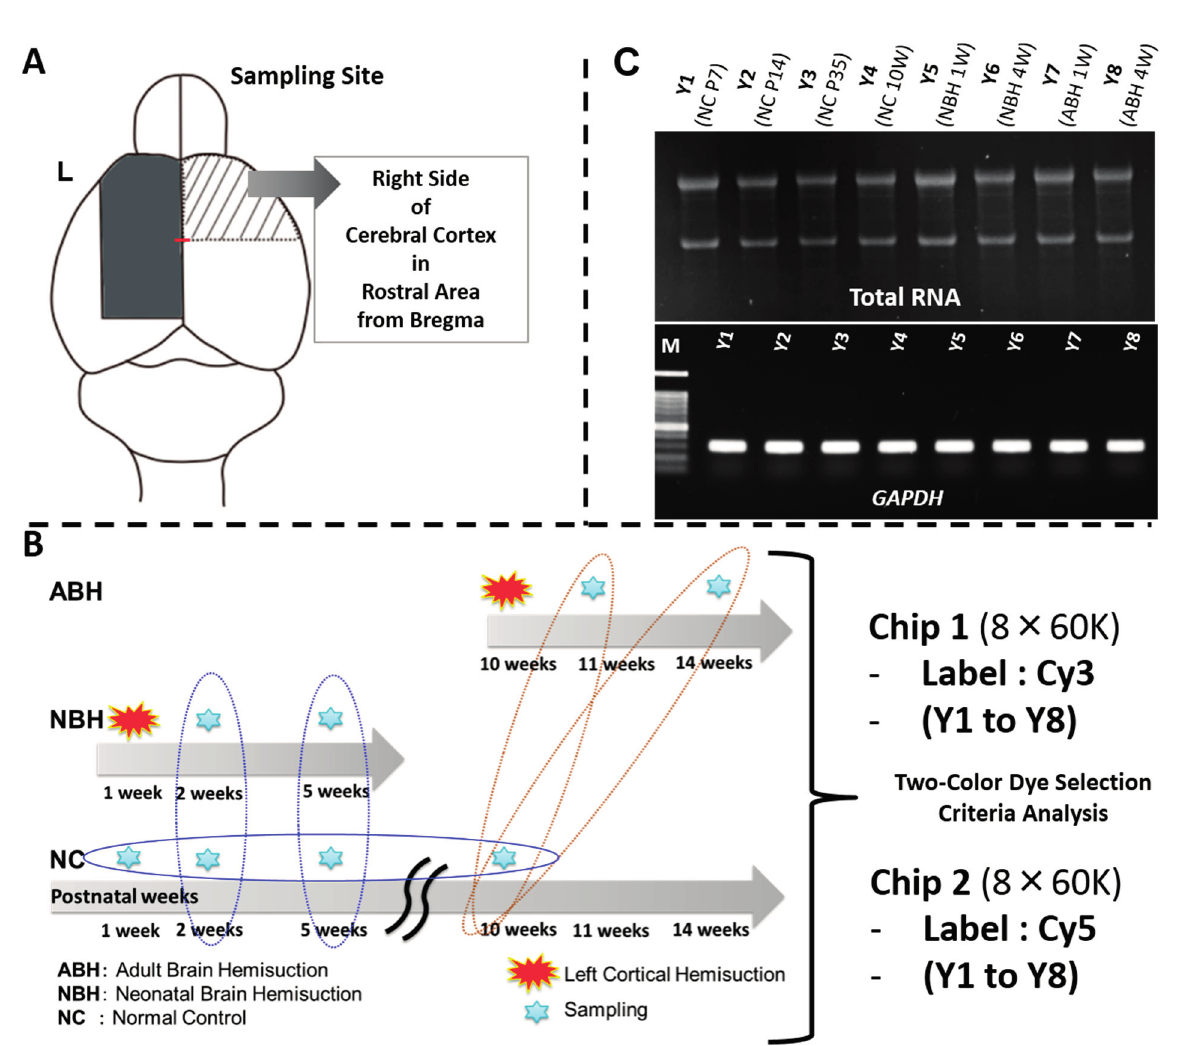
Figure 5. DNA microarray analysis of the brain region. ( A ) Sampling site of mouse whole brain and cerebral cortex sampled; ( B ) Sampling points and DNA microarray analysis on two 8 × 60 K microarray chips using a two-color approach. Brain tissues were ground to a fine powder in liquid nitrogen and stored at − 80 °C; and ( C ) Total RNA extraction from the finely powdered brain tissues. Total RNA quality was confirmed by agarose-gel electrophoresis. Gel images for the GAPDH gene expression as a positive control by RT-PCR, and the PCR product bands stained with ethidium bromide. For further details, see the Experimental